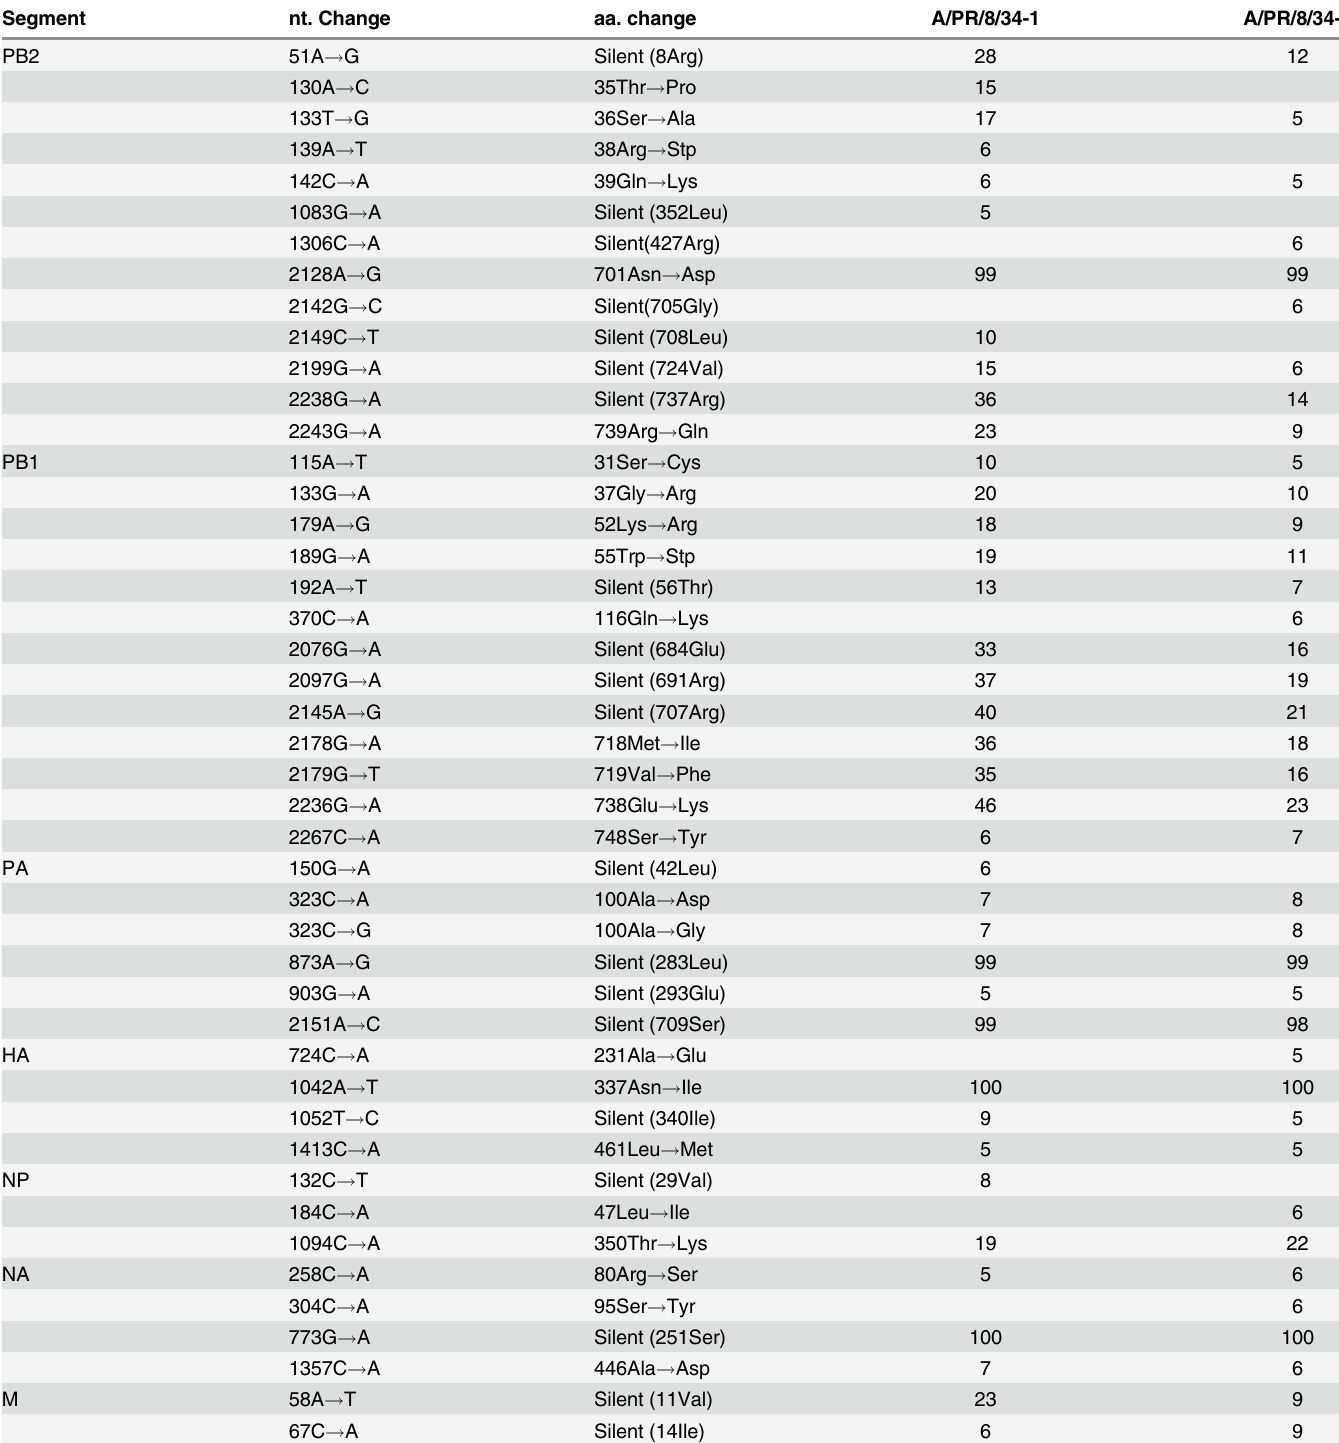
Table 3. Percentage of mutations ( (cid:3) 5%) emerged in A/PR/8/34 viruses 1 and 3 genomes that were subjected to RNA library preparation followed by HiSeq sequencing. Note: These mutation percentages were calculated per comparison of A/PR/8/34 strains 1 and 3 genomes with the